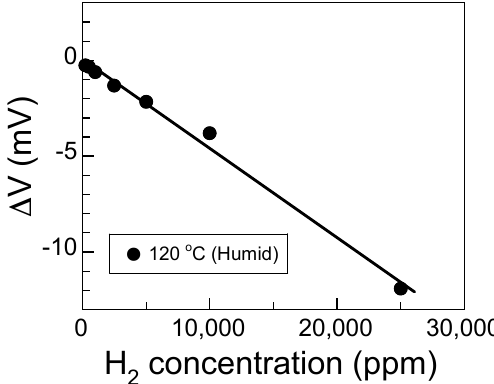
Figure 5. The relationship between the sensor response and the H 2 concentration in humid air at 120 ° C. The solid line shows the least-squares linear fit.